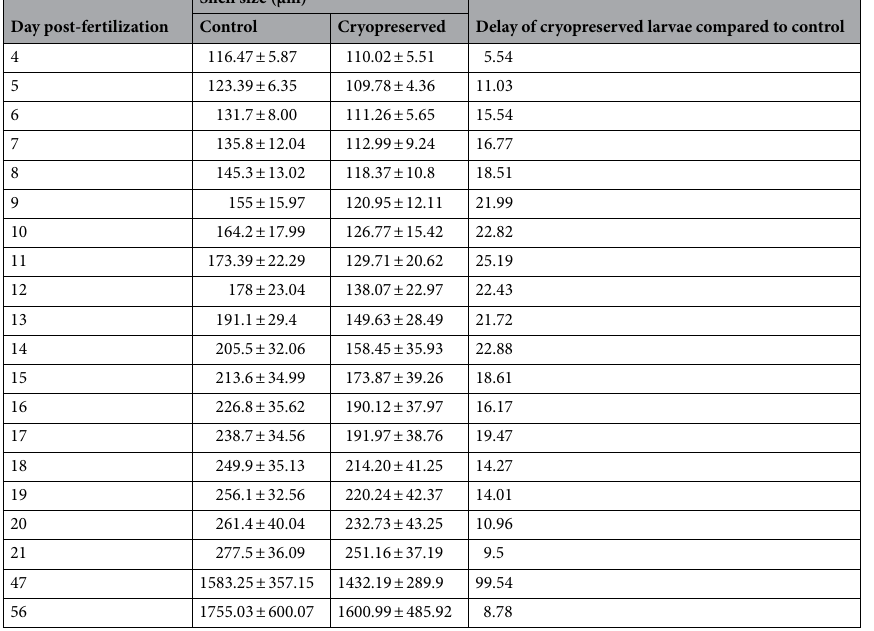
Table 1. Larval size (μm), measured on normal D larvae and delay of cryopreserved larvae compared to control group. Mean ± Standard Deviation (SD), n = 35 per tank, 4 tanks per treatment.